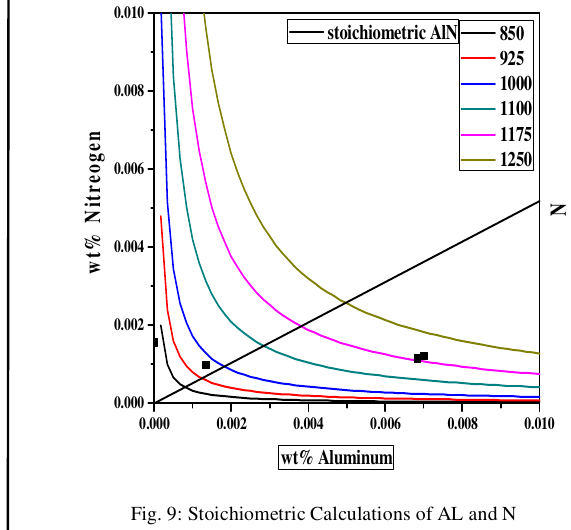
Fig. 9: Stoichiometric Calculations of AL and